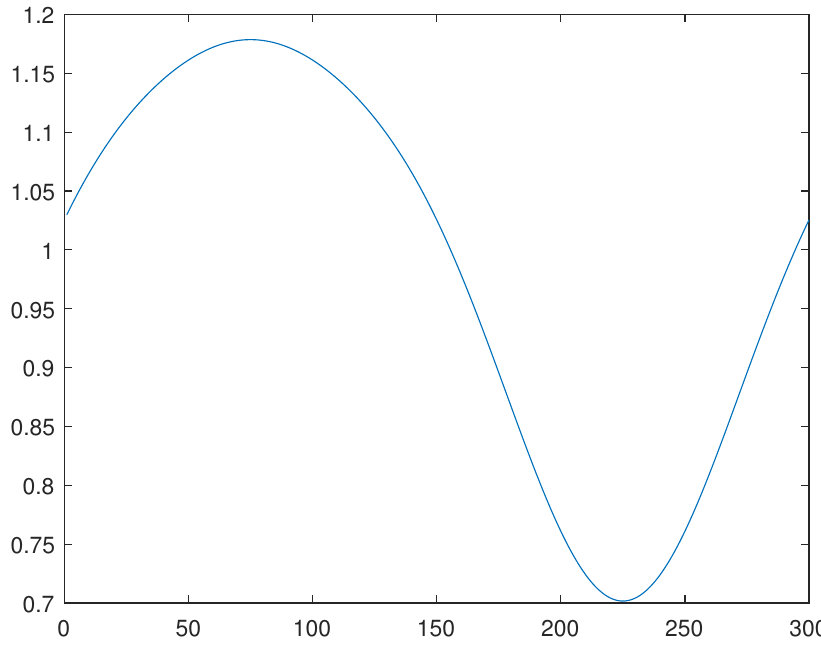
Figure 7. Line 6, solution u 6 ( x ) through the general method of lines.